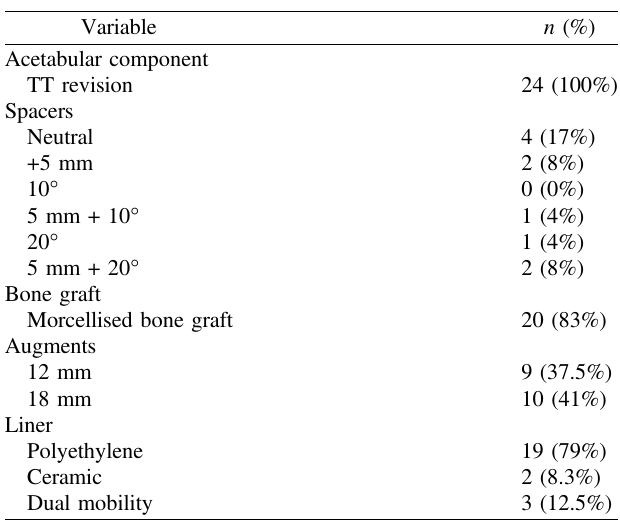
Table 2. Type of implant, spacers, bone graft and cranial augmen- tation, and liner surface